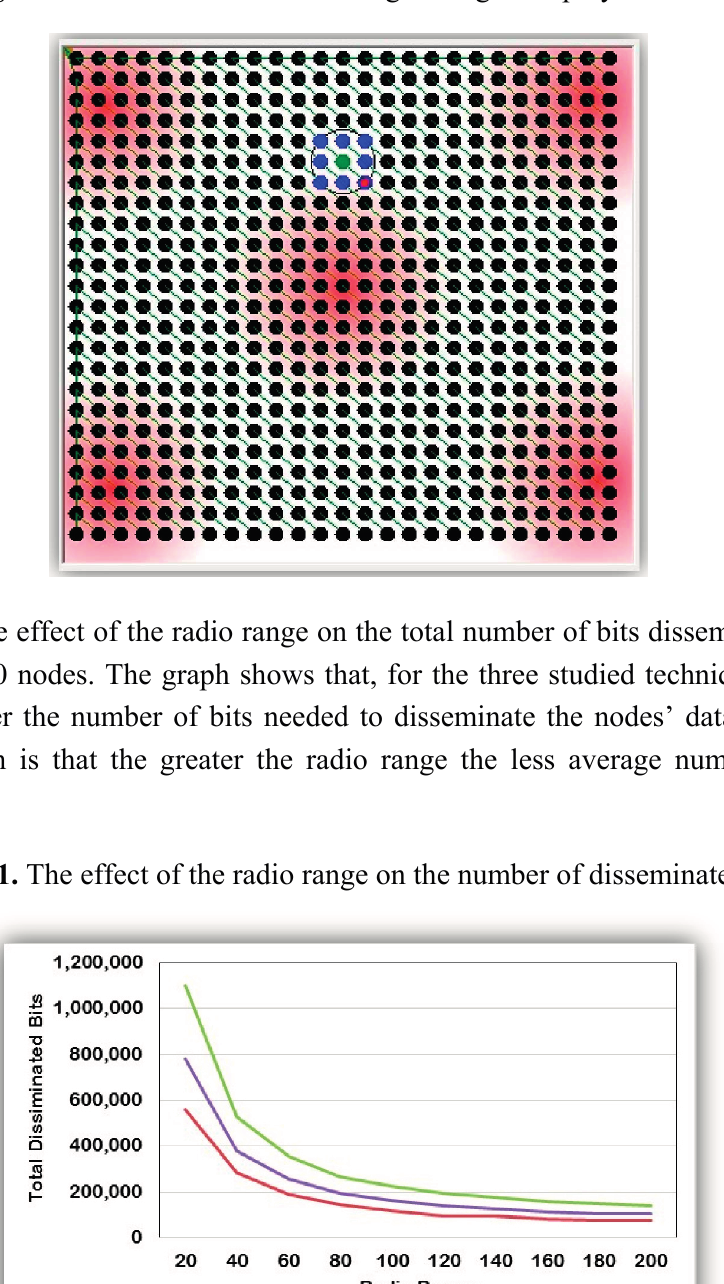
Figure 10. Disseminated bits through 600 grid-deployed nodes.